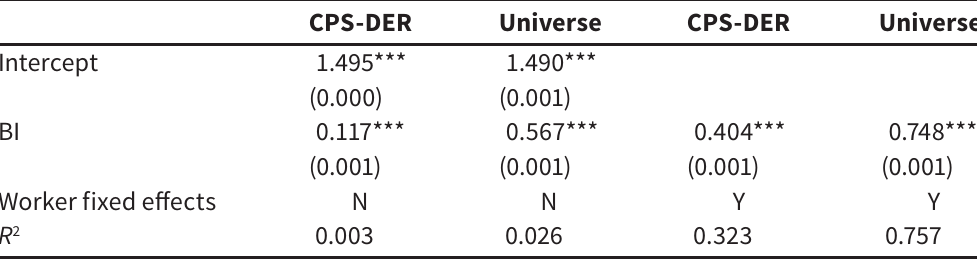
Regression of total number of jobs (including BI) on